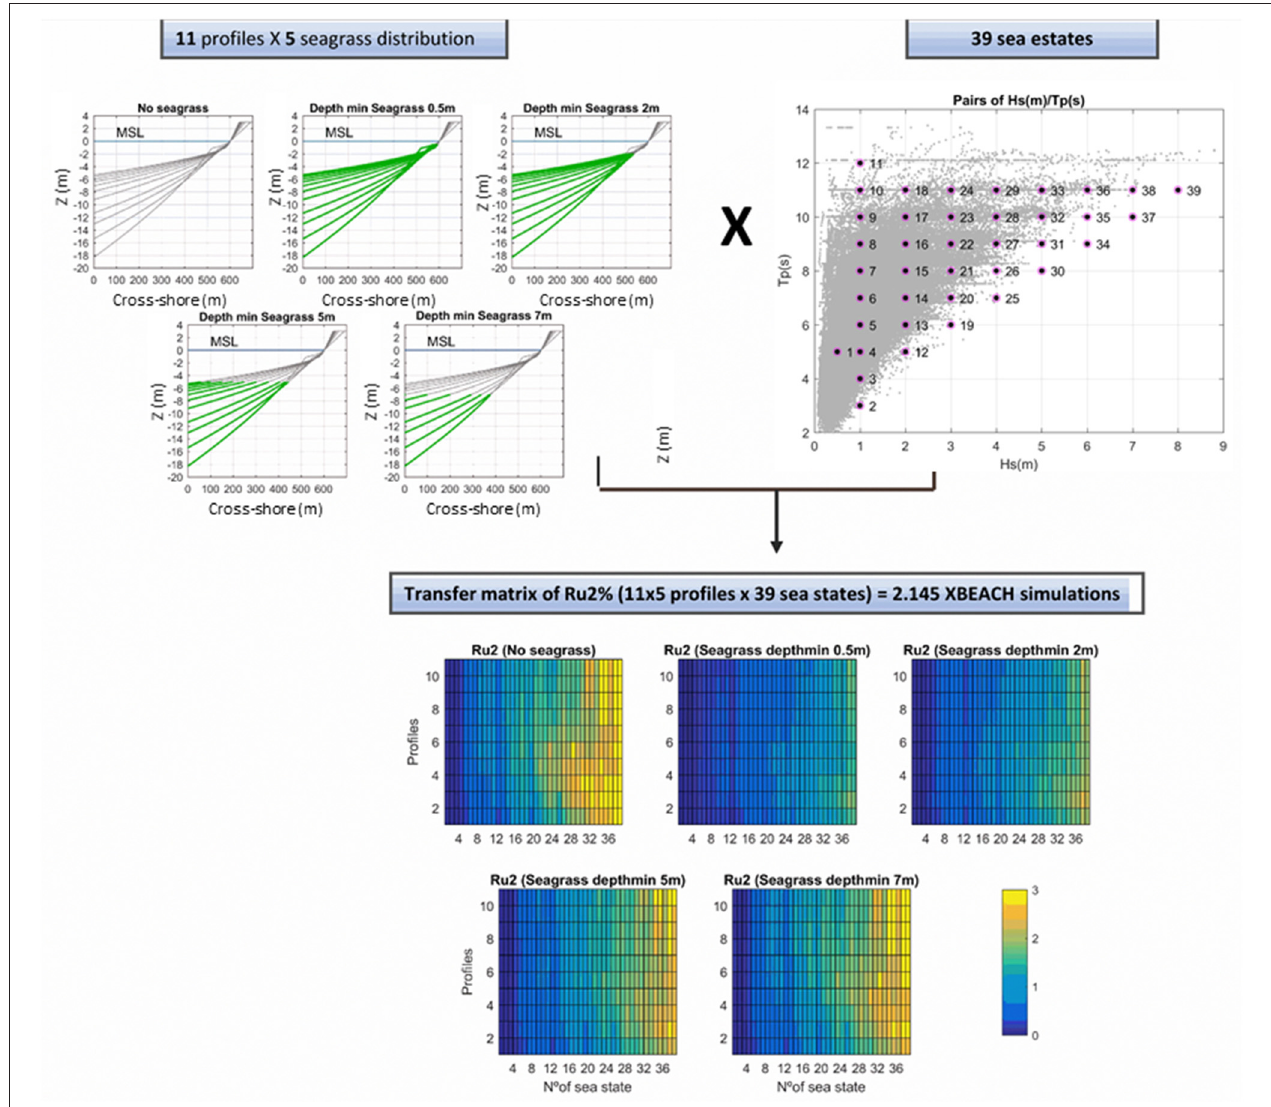
FIGURE 5 | Sketch of the methodology followed to obtain the transfer matrix of wave Runup (bottom) as a function of beach equilibrium profiles and seagrass distribution (top left) and nearshore wave conditions, pairs of Hs (m)/Tp (s) considered in XBEACH propagations scattered with black dots and the values are explicitly showed in an auxiliary table (auxiliary information in this